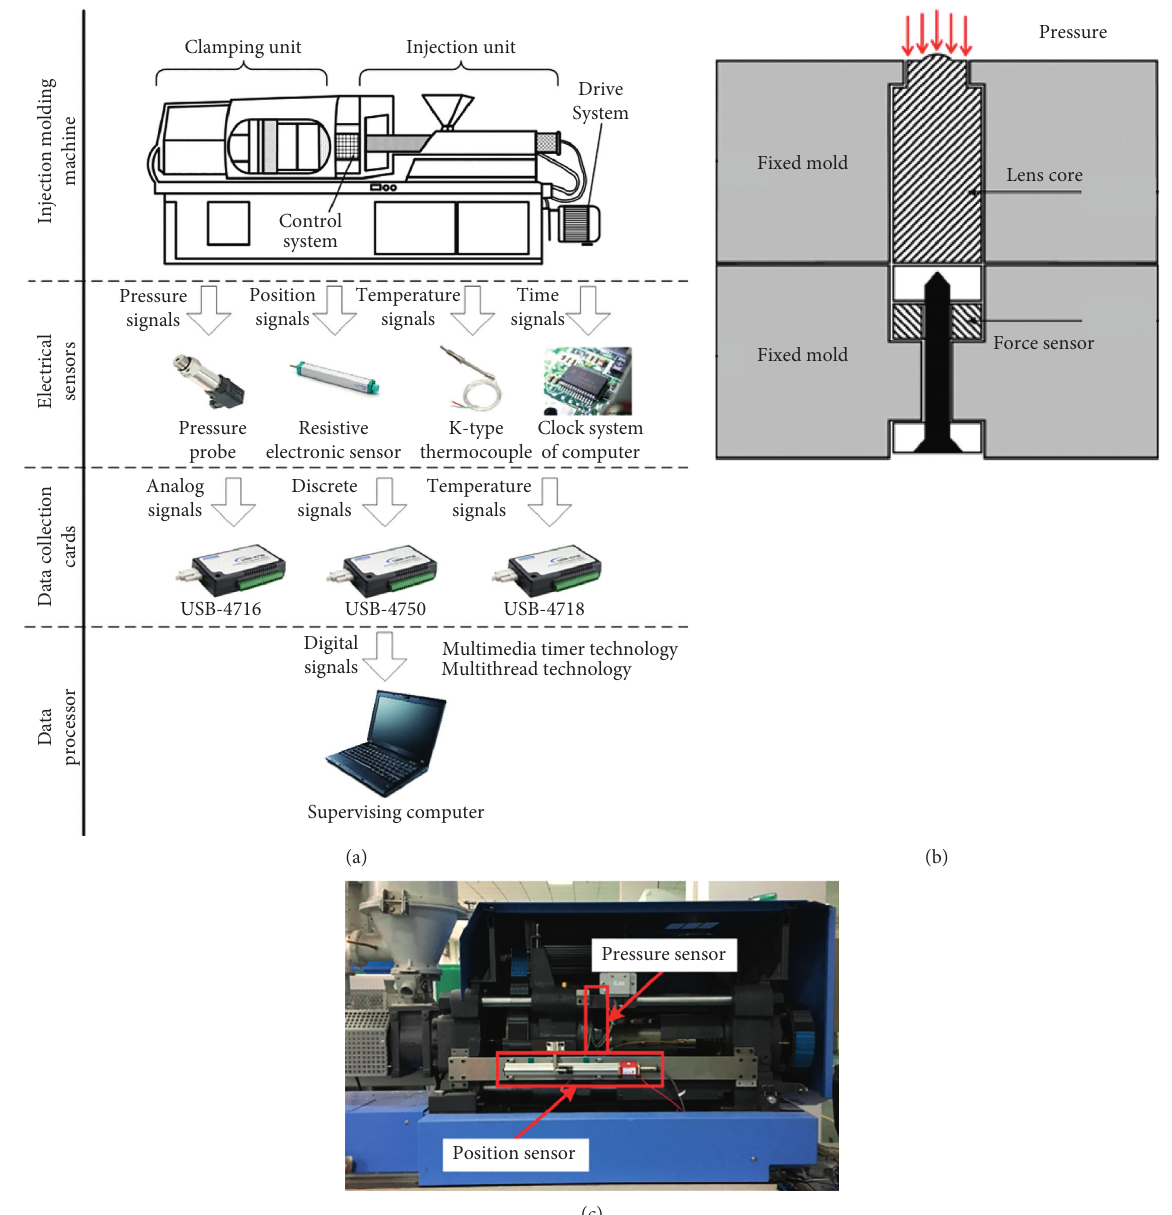
Figure 2: (a) Conventional sensors used in online sensing of injection molding process [9]. (b) Illustration of an indirect pressure sensor [10]. (c) The injection molding machine with respect to position and pressure sensors equipped [11].